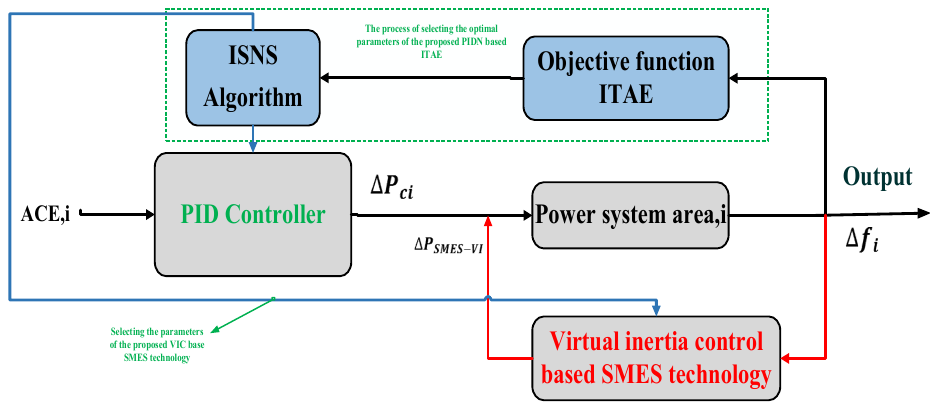
Figure 9. The process of selecting the optimal parameters of the proposed control strategy.